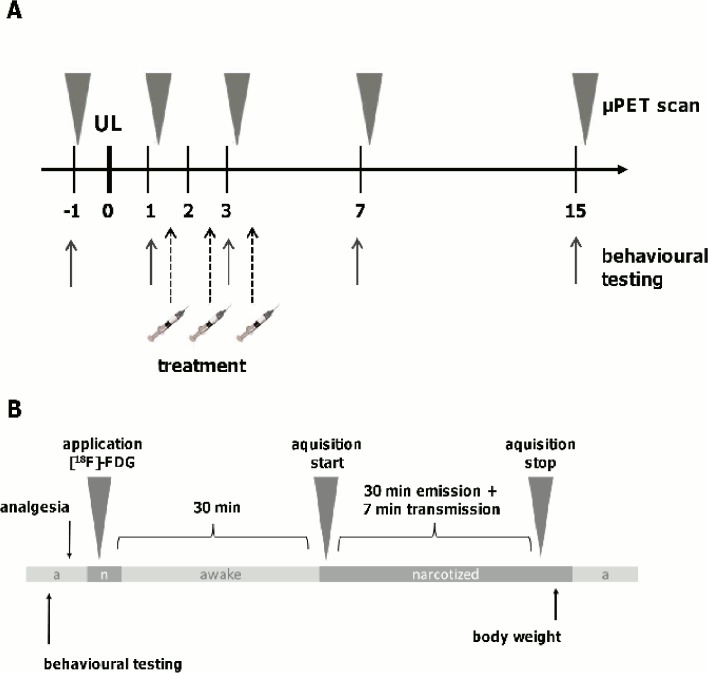
Study design and time course of treatment, μPET scanning and behavioural testing.A) N-acetyl-DL-leucine, N-acetyl-L-leucine or N-acetyl-D-leucine was administered intravenously on days 1, 2 and 3 after unilateral labyrinthectomy (UL). Sequential whole-brain [18F]-FDG-μPET and behavioural testing was done before and on days 1, 3, 7, 15 after UL. B) At the respective time points after behavioural testing, anaesthesia was induced with isoflurane and [18F]-FDG was injected. After awaking, animals were allowed to move freely until anaesthesia was induced again with isoflurane for the μPET-scan. The scan was started 30 min after [18F]-FDG injection. A 30-min emission recording was initiated followed by a 7-min transmission scan.